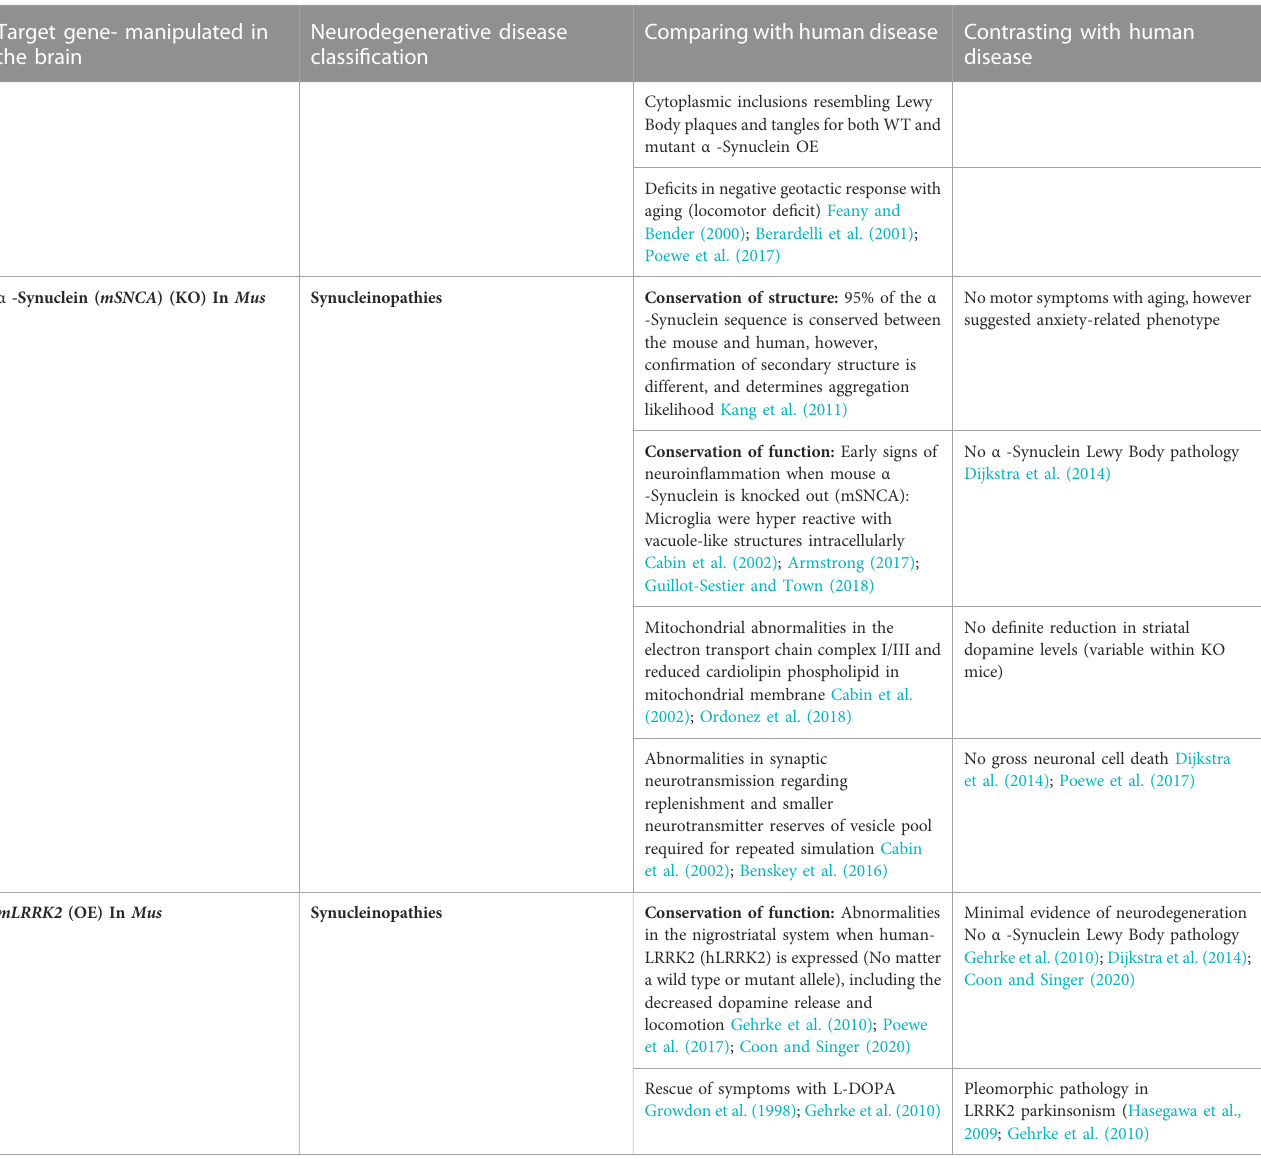
TABLE1( Continued )Modelsof Musmusculus (Mouse)and Drosophilamelanogaster (Fruit fl y)forstudyingthehumanneurodegenerativedisease.Thereportedmodels represent Tauopathies, β -amyloidopathies, and Synucleinopathies in the brain. Models include Knock-out (KO), Knock-in (KI), Knock-Down (KD), and Over-Expression (OE) of hallmark genes for each of the three categories of neurodegenerative disease listed above. There is a column describing similarities in pathology between species and another column for differences. With each example made, there are references to the literature for more information about the model organism ’ s pathologies and similar or contrasting human pathology for